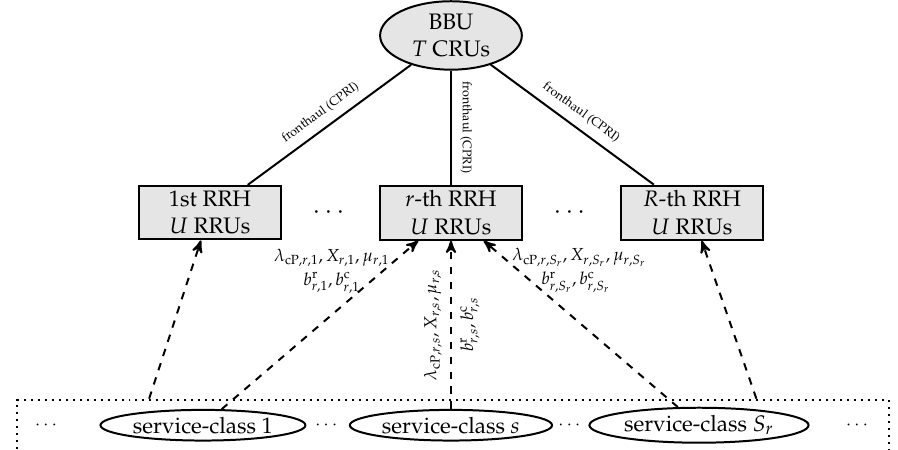
Figure 1. The proposed c-MC-SC